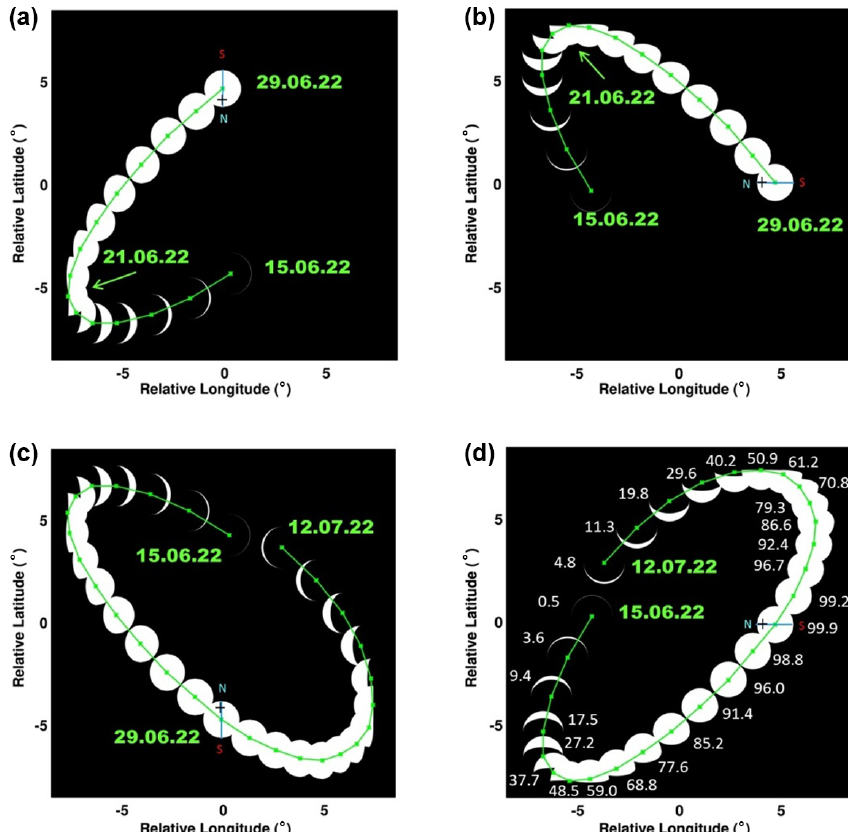
Figure 10. Positions of the Earth for different Moon observers. (a) Position of the Earth’s center and Earth’s phases during 15–29 June 2022 (15 points, green line) for an observer located on the lunar south pole (the point S in Fig. 6). The Earth is almost completely illuminated on 29 June 2022, while its axis is tilted to the Sun at an almost maximum angle (summer in the Northern Hemisphere), which creates good conditions for observing the Earth’s North Pole (marked with a cross and the letter N). (b) Earth’s phases and visible trajectory for the same period for an observer on the equator near longitude 90 ◦ W (the point W in Fig. 6). (c) Position of the Earth center and Earth’s phases during 15 June–12 July 2022 (28 points, green line) for an observer located on the lunar north pole (the point N in Fig. 6). (d) Earth’s phases and visible trajectory for the same period for an observer on the equator near longitude 90 ◦ E (the point E in Fig. 6).